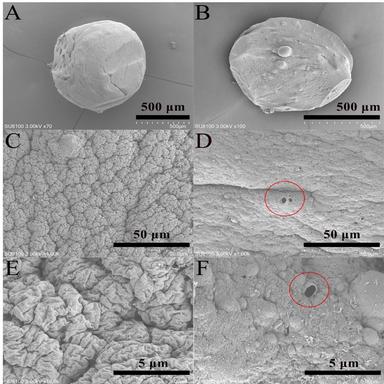
The scanning electron microscopy (SEM) analysis for the surface of the prepared PM. A, C, and E are the surface of the dry PM; B, D and F are the surface of the swelling PM that are observed at 70×, 1000×, and 10,000× respectively.